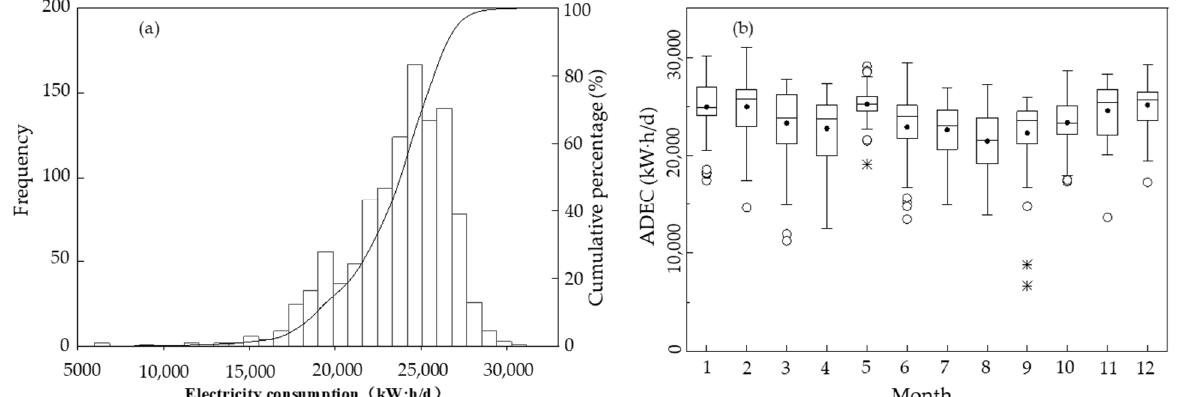
Figure 7. ( a ) Probability distribution and ( b ) monthly distribution of ADEC. The solid circle ( • ) represents the average. Outliers are marked by a hollow point ( ◦ ) and extreme points are marked by an asterisk (*).